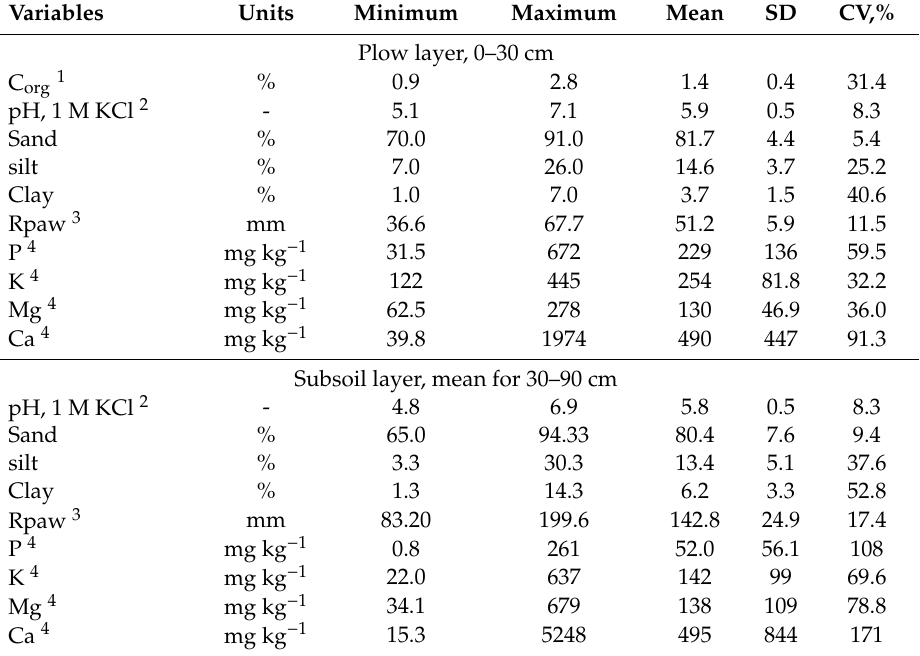
Table 1. Soil properties at the beginning of the winter oilseed rape / winter triticale crop rotation.